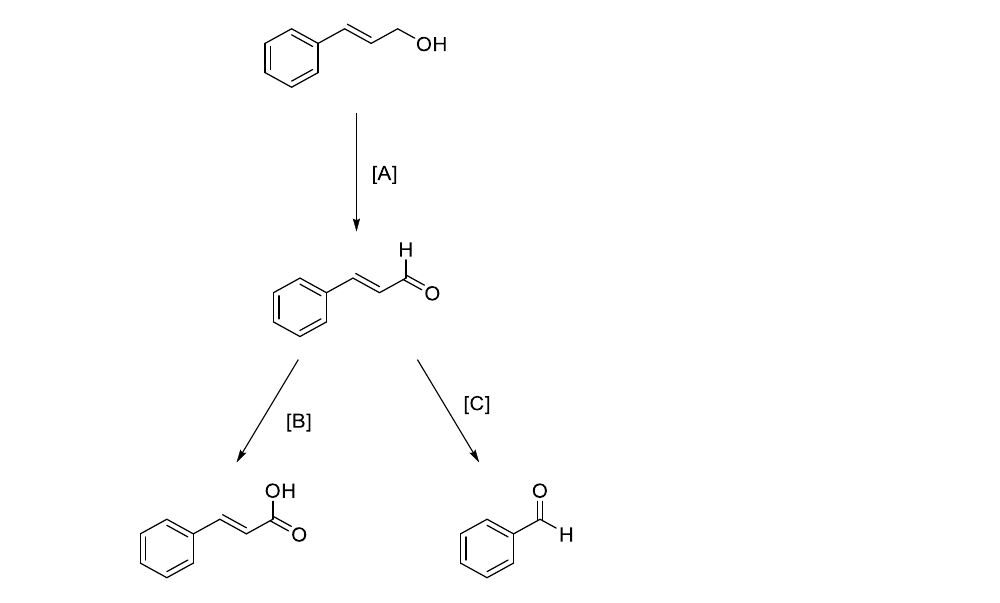
Scheme 4. Proposed paths leading to the formation of overoxidation products